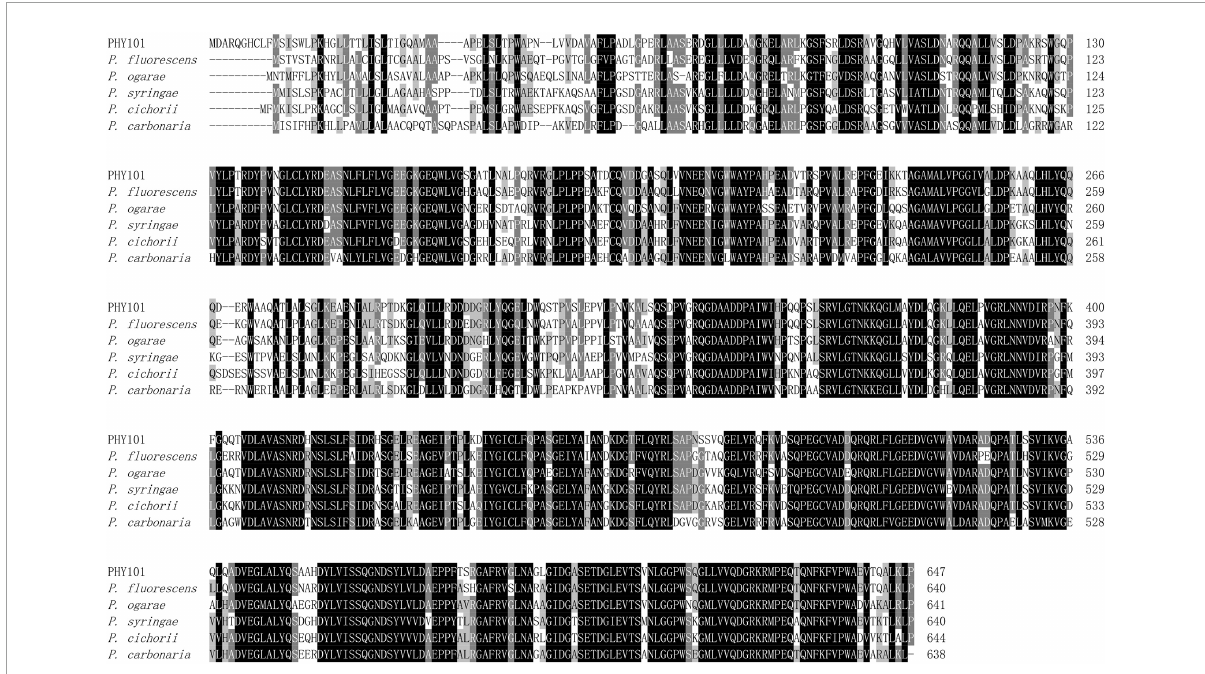
FIGURE6 Multiple protein sequence alignment of phytase between PHY101 (OM935859) from Pseudomonas mandelii GS10-1 and other similarly species. The DNAMAN was utilized to perform the alignment for Pseudomonas fluorescens (Q4KAB7), Pseudomonas fluorescens (C3JXS5), Pseudomonas ogarae (G8Q0X6), Pseudomonas syringae (Q880D0), Pseudomonas cichorii (A0A3M4VZG6), and Pseudomonas carbonaria (A0A7U7I973). The consensus residues are identical in all sequences and the majority of sequences are shaded separately in a black and